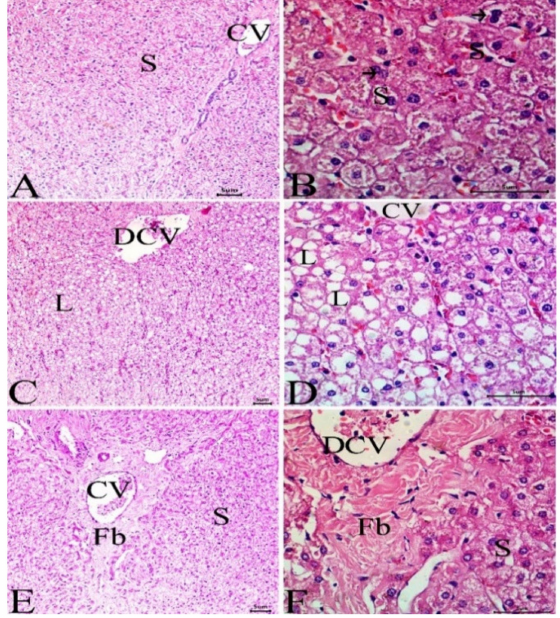
Figure 6. Sections in the liver of camels at site 1 ( A , B ) showing normal liver architecture with normal hepatocytes (arrow), sinusoids (S), and central vein (CV), site 2 ( C , D ) showing mild dilation of the central vein (DCV) and few lipid droplets (L) and site 3 ( E , F ) showing dilated central vein (DCV), lipid droplets and fibrotic changes (Fb). (H&E, Scale bar = 50 µ m).